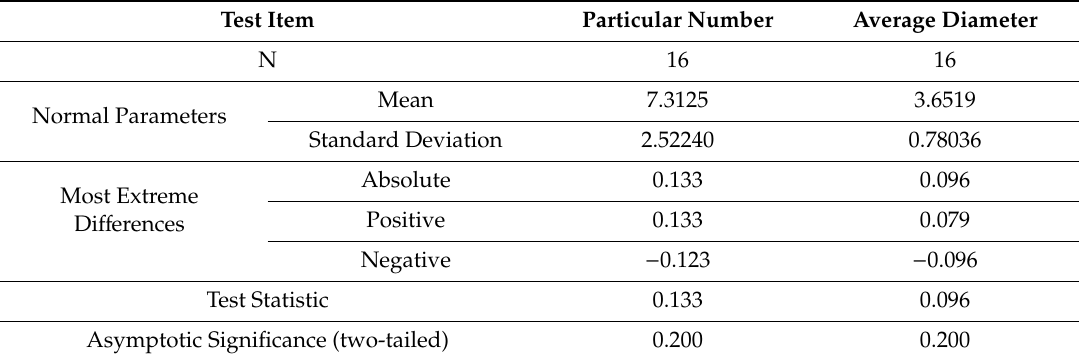
Table 6. Results of Kolmogorov–Smirnov test.